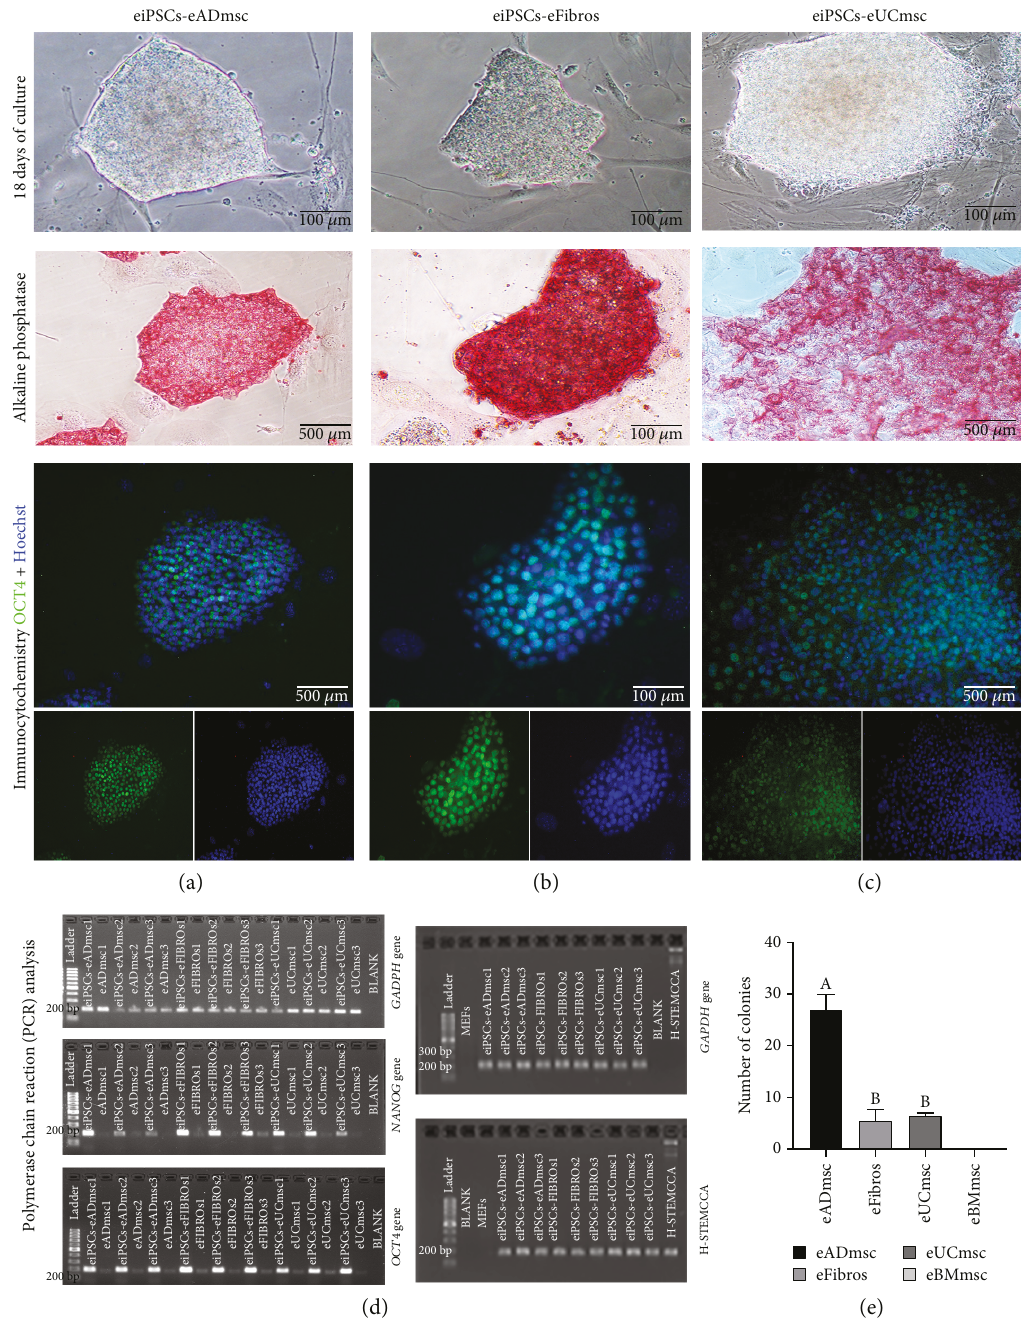
Figure 2: Equine iPSCs on day 18 after transduction from (a) adipose tissue mesenchymal cells, (b) fi broblasts, and (c) umbilical cord tissue mesenchymal cells, 200x. Alkaline phosphatase-positive equine iPSC colonies were induced from each cell type: (a) adipose tissue mesenchymal cells, 100x; (b) fi broblasts, 200x; (c) umbilical cord tissue mesenchymal cells, 100x. In addition, images present the immunocytochemistry expression of merged OCT4, OCT4/FITC, and Hoechst staining: (a) adipose tissue mesenchymal cells, 100x; (b) fi broblasts, 200x; (c) umbilical cord tissue mesenchymal cells, 100x. (d) Transcript expression of GAPDH, NANOG, and OCT4 in equine adipose tissue mesenchymal cells, umbilical cord tissue mesenchymal cells, and fi broblasts before and after pluripotency induction. NANOG and OCT4 expression levels are enhanced after cell reprogramming. Also in (d), con fi rmation of GAPDH and STEMCCA expression in equine iPSCs by conventional PCR. (e) Graph showing the total production of eiPSC colonies using hOSKM. No colonies were formed from the bone marrow mesenchymal cells. Di ff erent letters indicate signi fi cantly di ff erent results ( P < 0 05